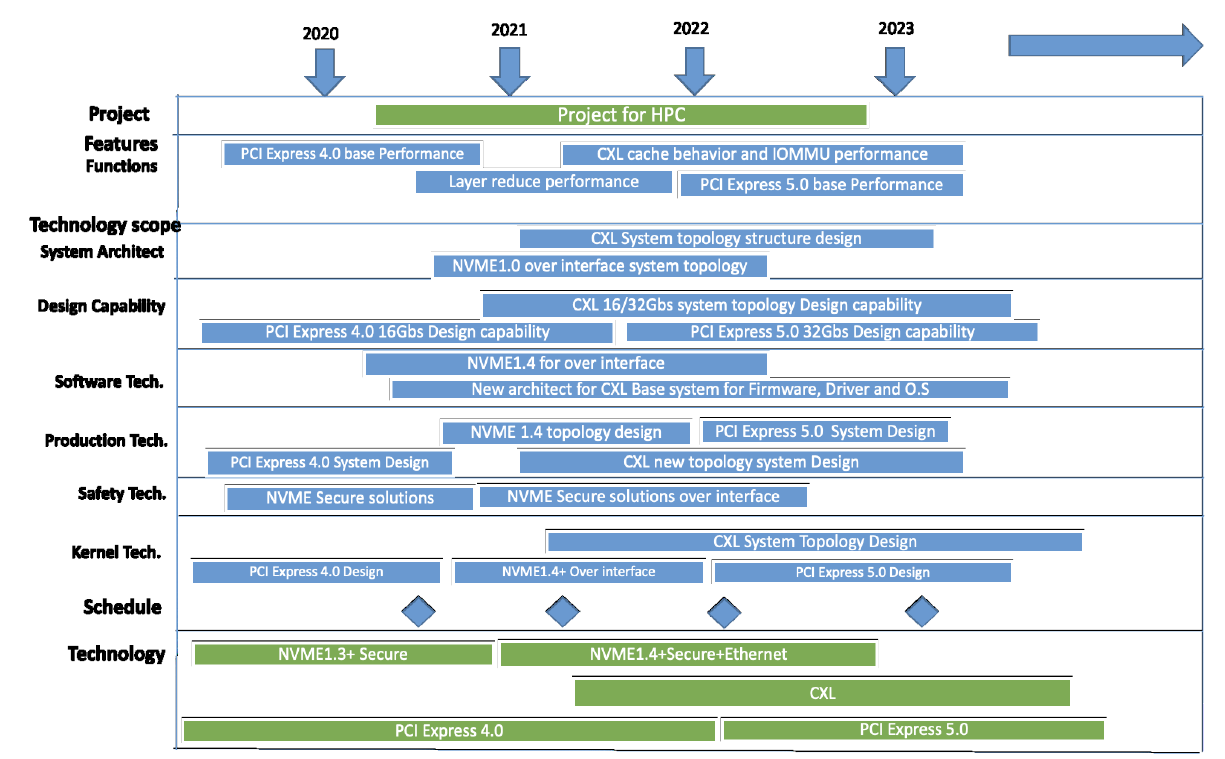
Figure 19. Technology strategy roadmap for high-performance cloud